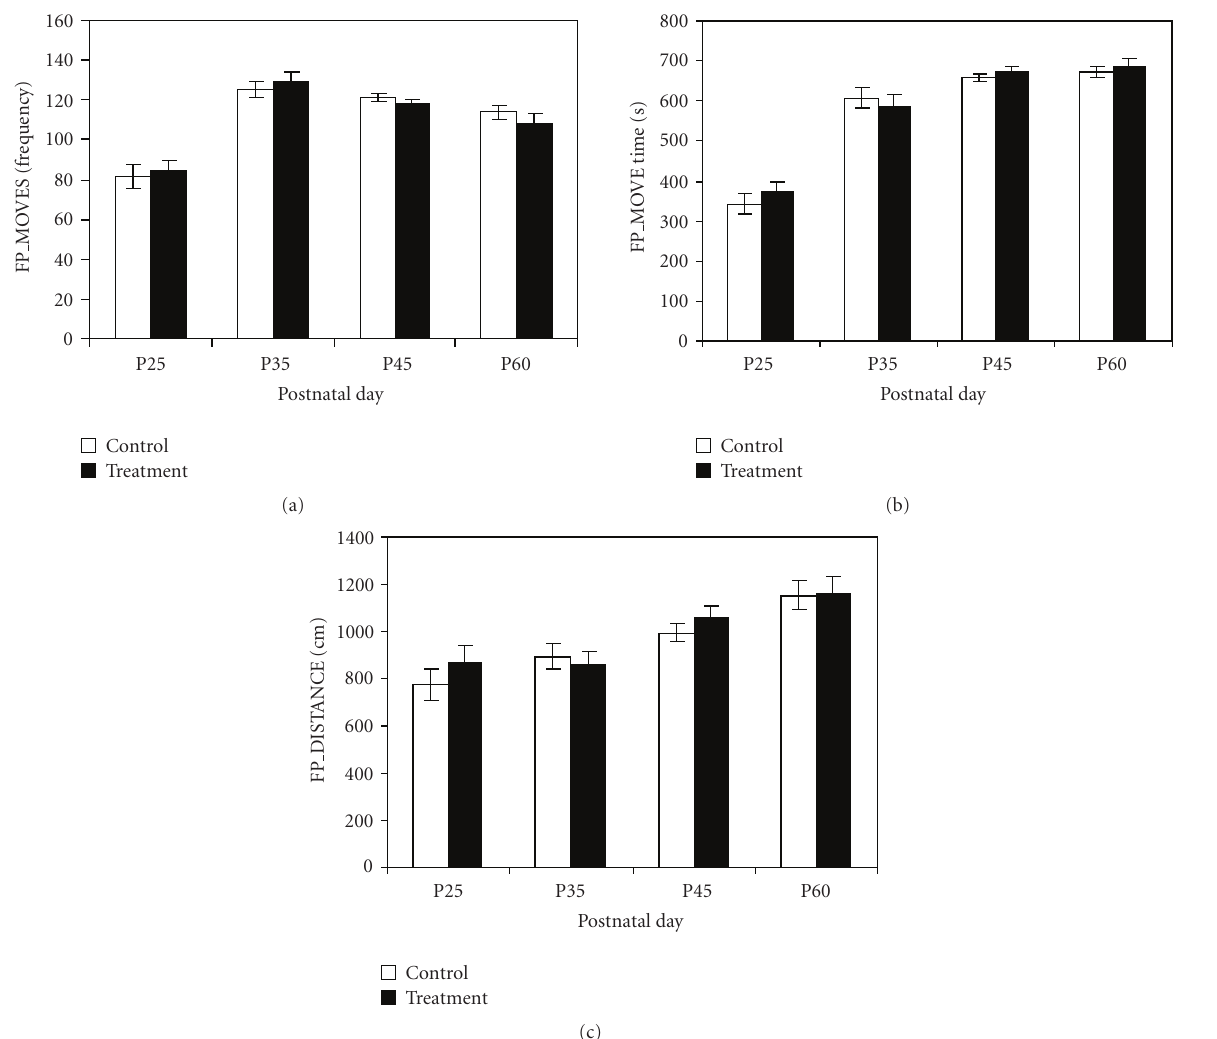
Figure 1: Open field test performance in forepaw sensorimotor deprived group (treatment) and sham-operated control group (control). Forepaw sensorimotor deprivation did not a ff ect spontaneous locomotor activity of the rats at PN25, PN35, PN45, and PN60 ( P > . 05). The Three indices (a) FP moves, (b) FP move time, and (c) FP distance were shown as